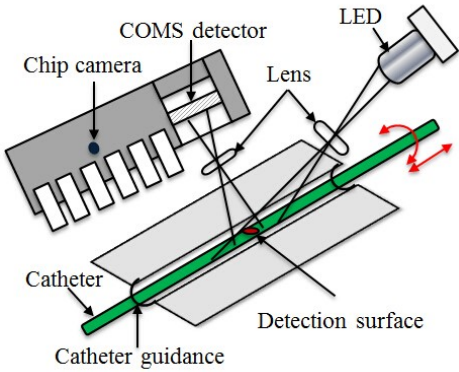
Figure 10. Non-contact catheter interventional kinematics measurement principle.